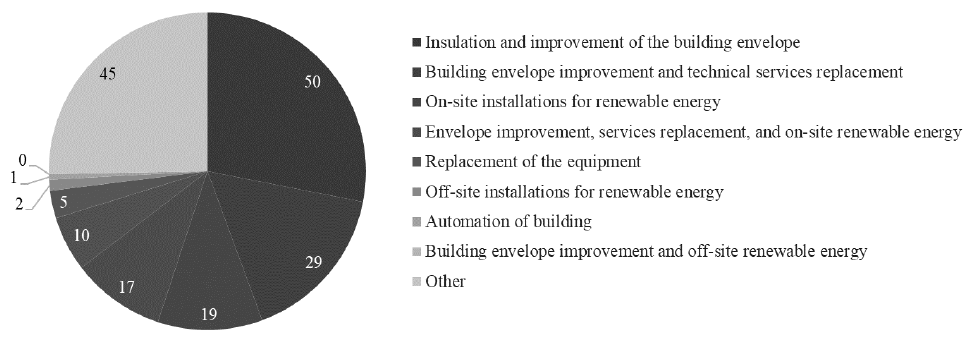
Figure 2. Types of measures to improve the building energy performance covered by the case studies.